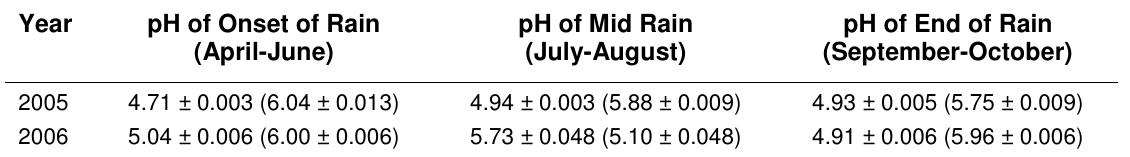
pH of Rainwater Samples in Port Harcourt between April and October, 2005 and